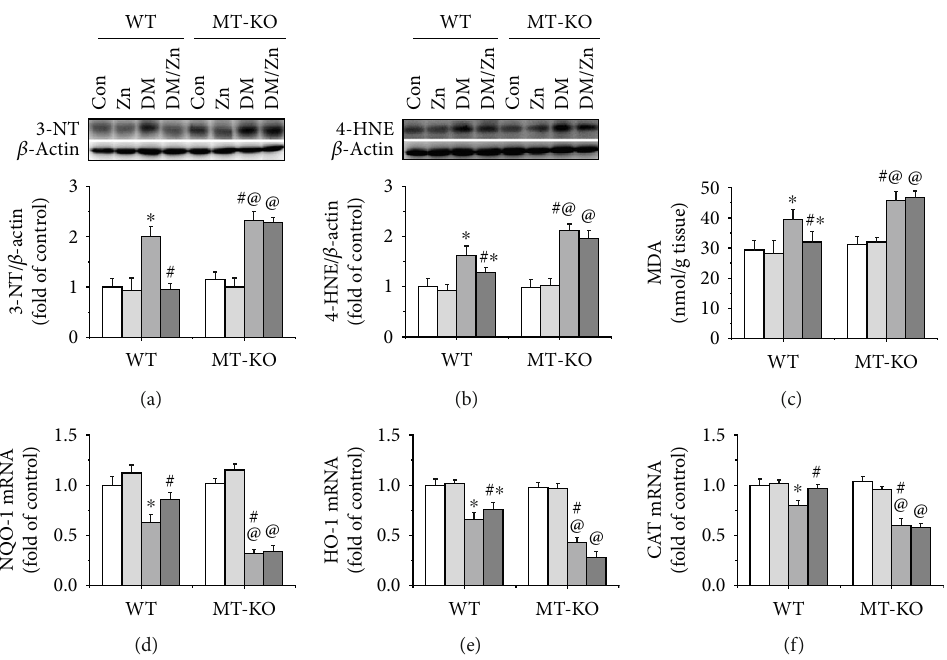
Figure 9: The role of endogenous MT in zinc supplementation induced an antioxidative e ff ect in the liver of type 2 diabetic mice. Oxidative stress is regarded as the initial pathogenesis of type 2 diabetes-induced liver injury. In the present study, classic oxidative markers including 3- NT (a) and 4-HNE (b) were measured by western blot. The end-product of lipid peroxidation, MDA (c), was determined by the ELISA kit. The mRNA levels of antioxidants including NQO-1 (d), HO-1 (e), and CAT (f) were determined by real-time PCR. Data are presented as the mean ± standard deviation ( n = 8 /group). ∗ P < 0 : 05 vs. the control (Con) group in WT mice; # P < 0 : 05 vs. the type 2 diabetes (DM) group in WT mice; @ P < 0 : 05 vs. the control (Con) group in MT-KO mice.